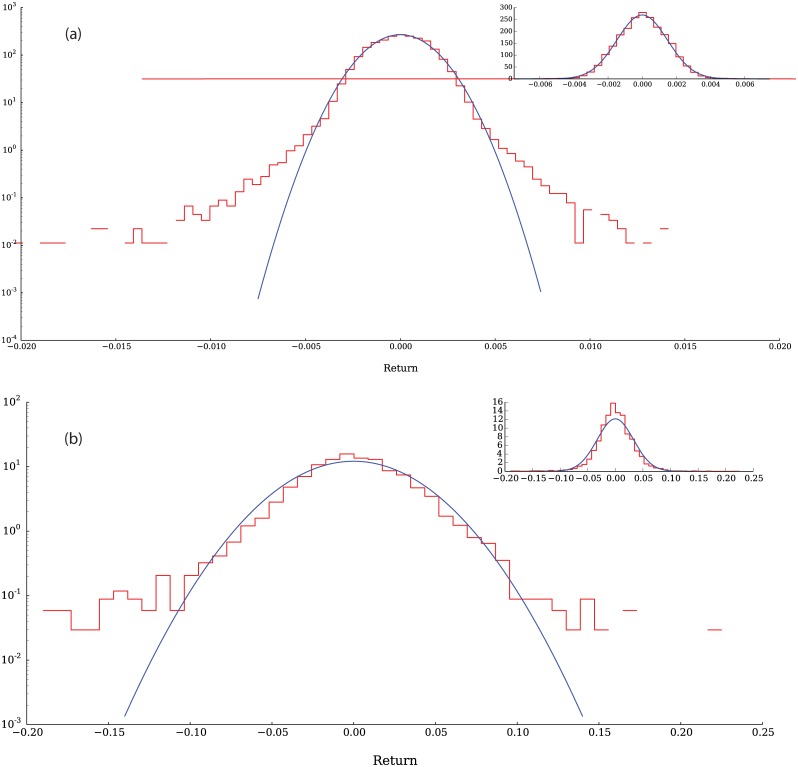
Returns PDF from the simulation (a) and comparison with empirical data from United States Steel Corporation, Inc.The tails of the distribution (red line) are clearly heavier than those of a normal distribution (blue line). Data obtained from QuantQuote [43].